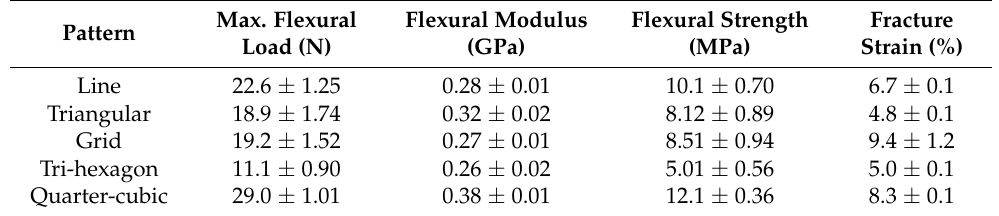
Figure 11. ( a ) Edgewise force-extension; ( b ) stress–strain behavior of different infill patterns; ( c ) Comparison of Edgewise flexural strengths for different infill patterns. Table 5. Summary of Experimental results for edgewise flexural properties at different infill patterns.